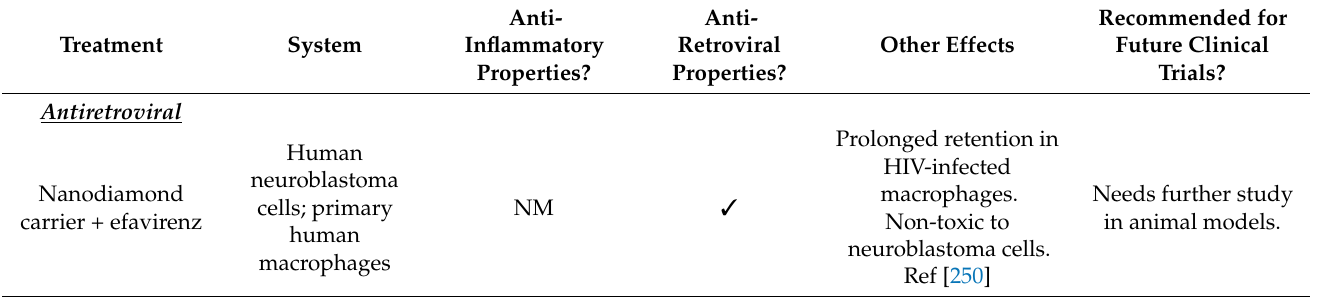
Table 2. Selected treatments in animal models and in vitro